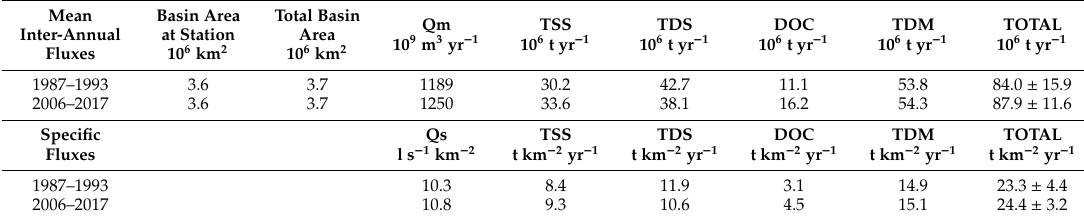
Table 3. Interannual mean fluxes and specific fluxes of water (Qs), total suspended sediment (TSS), total transported matter (TOTAL = TSS + TDM), for the two studied periods, 1987–1993 and 2006–2017.